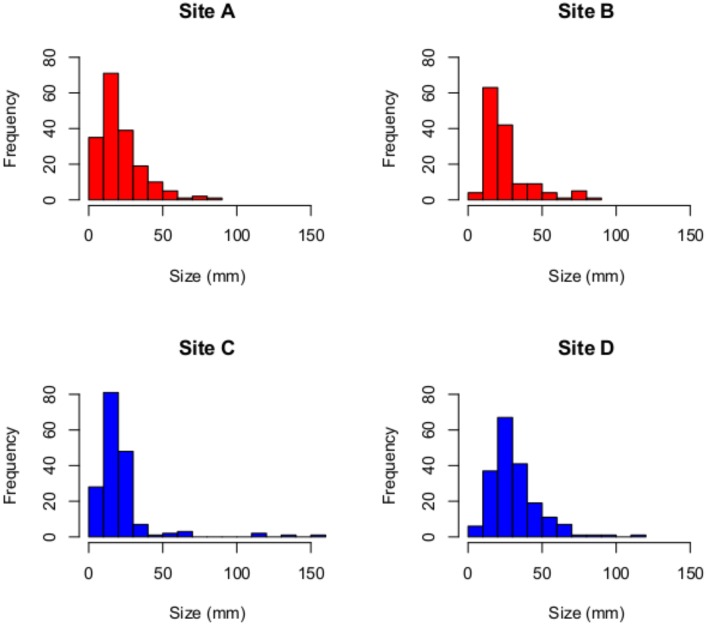
Distribution of Element Size.Histogram of size (mm) of elements at each of the four study sites; no significant differences between the sites indicated.